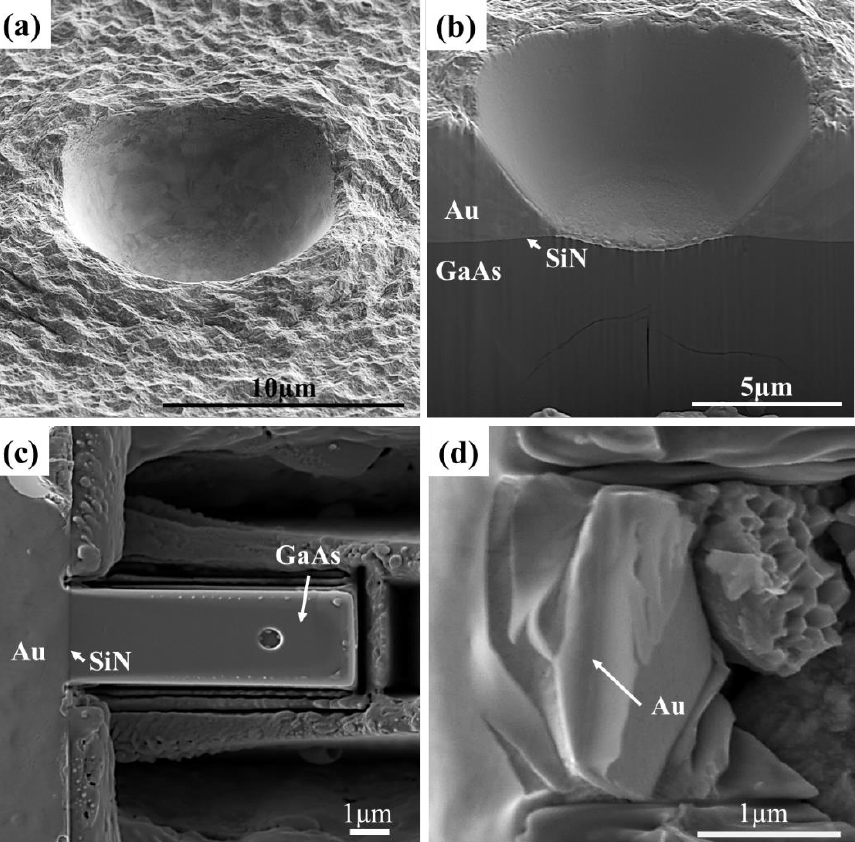
Figure 9. SEM micrographs of ( a ) an impression from a top-surface indentation showing appreciable plastic deformation in Au, ( b ) cross-section of the impression, ( c ) a micro-cantilever for the bending test, ( d ) post-mortem examination showing the detachment of GaAs cantilever from the base and the significant plastic deformation in Au.